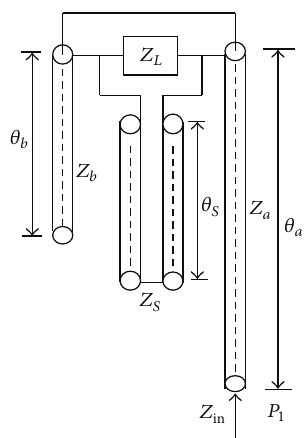
Figure 2: The equivalent circuit of the microstrip integrated